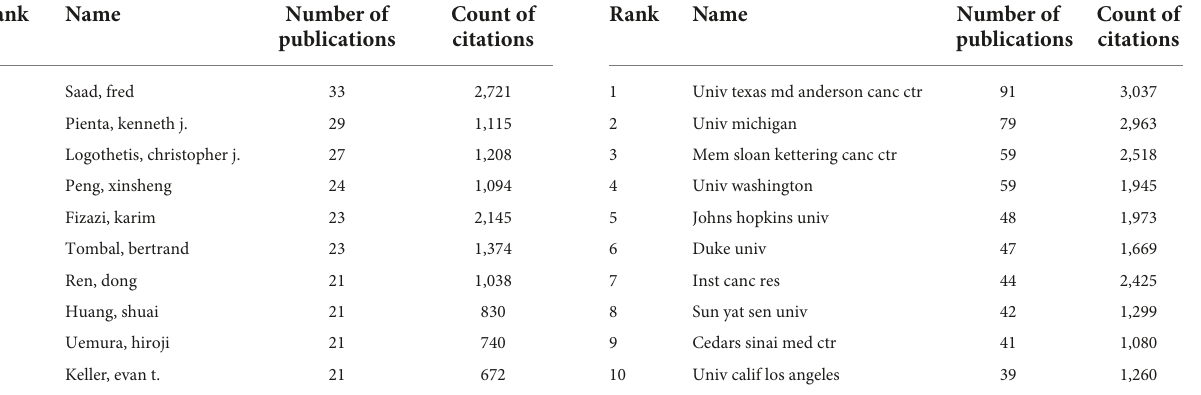
TABLE 2 The top 10 most active organizations related to PCa bone metastasis.